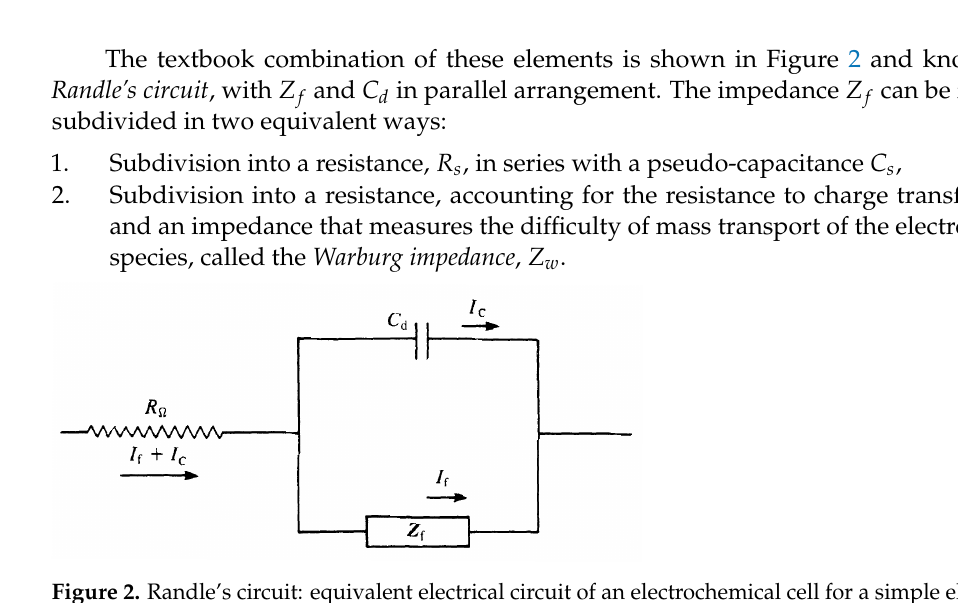
Figure 2. Randle’s circuit: equivalent electrical circuit of an electrochemical cell for a simple electrode process. Z f can be substituted with the series of R ct and Z w